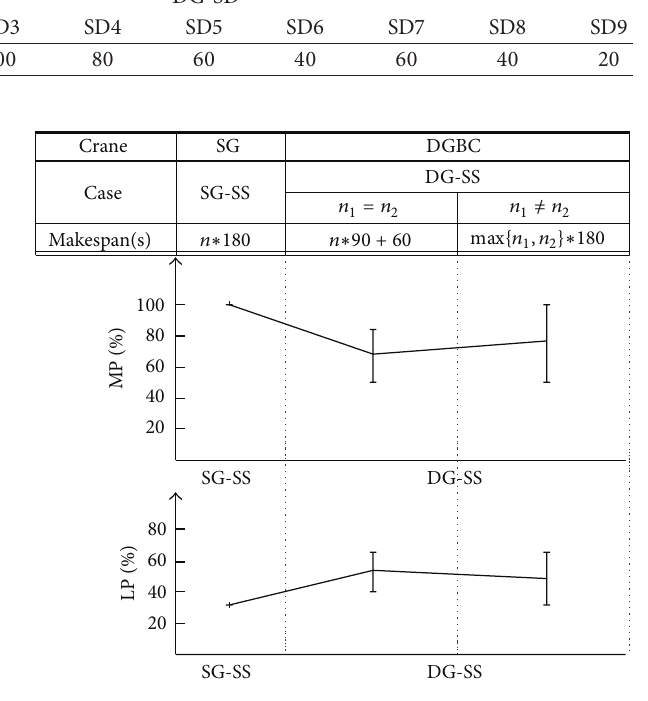
Figure 9: Comparison between SG-SS and